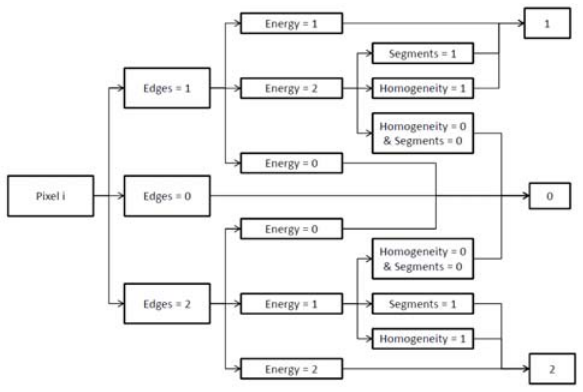
Fig. 1. CEST decision tree (description see in the text)